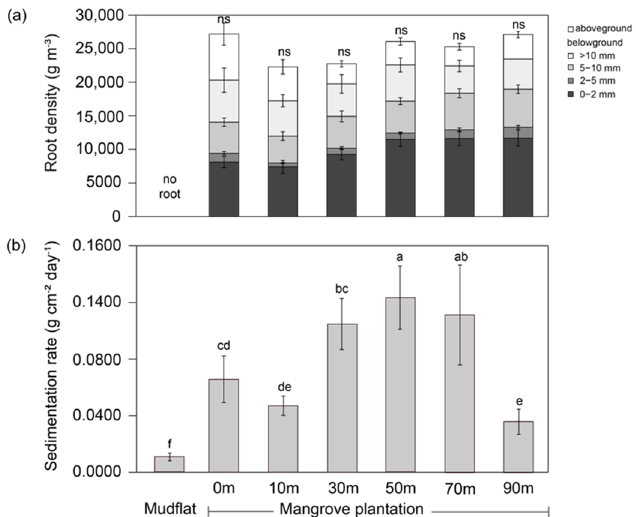
Figure 6. Root density (mean ± SE) across the shore ( a ) and average sedimentation rates at the sampling points on the mudflat and along the transect in the mangrove plantation from October 2020 to November 2021 ( b ). The different letters indicate significant differences based on a post hoc test (pairwise comparison) at p < 0.05. The designation ‘ns’ indicates a nonsignificant difference in distance from the